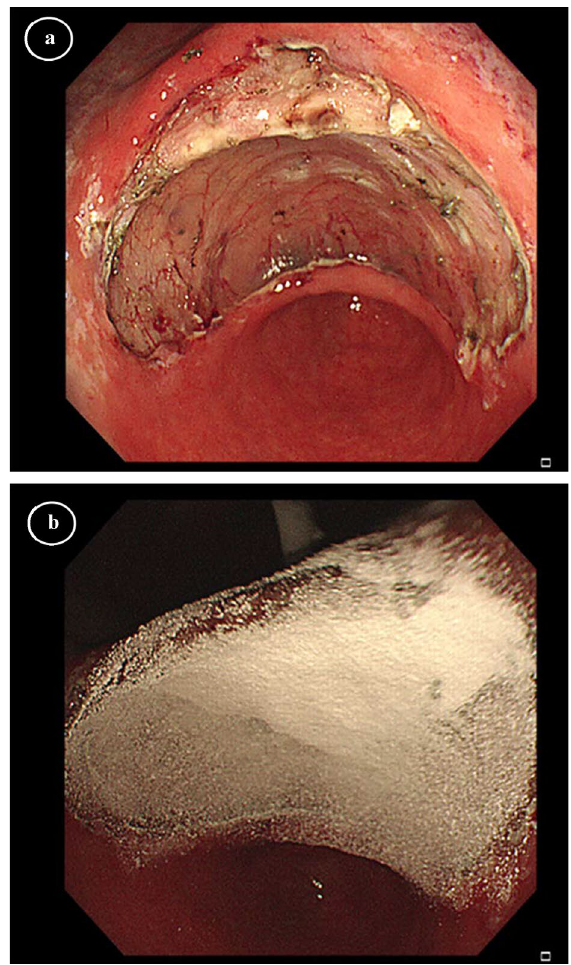
Figure 2. ( a ) A post-ESD ulcer located in the gastric angle with a longest diameter of 54 mm. ( b ) PEO adhesive applied to the ulcer surface. ESD endoscopic submucosal dissection, PEO polyethylene